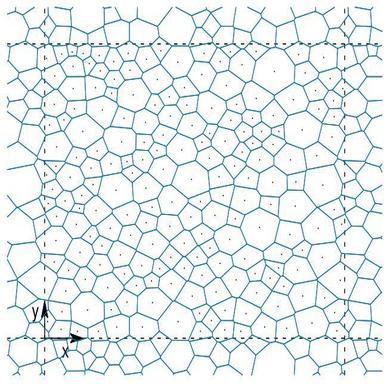
Example of the periodic system generated via MARS using a Laguerre-Voronoi tessellation. The grains containing points are those generated, with the dashed lines indicating the periodic repetitions.